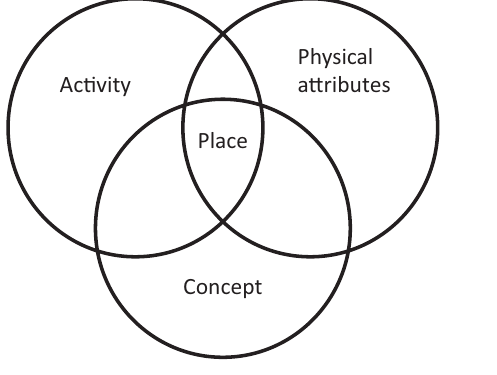
Figure 3. Canter’s (1977, p. 185) model of place.